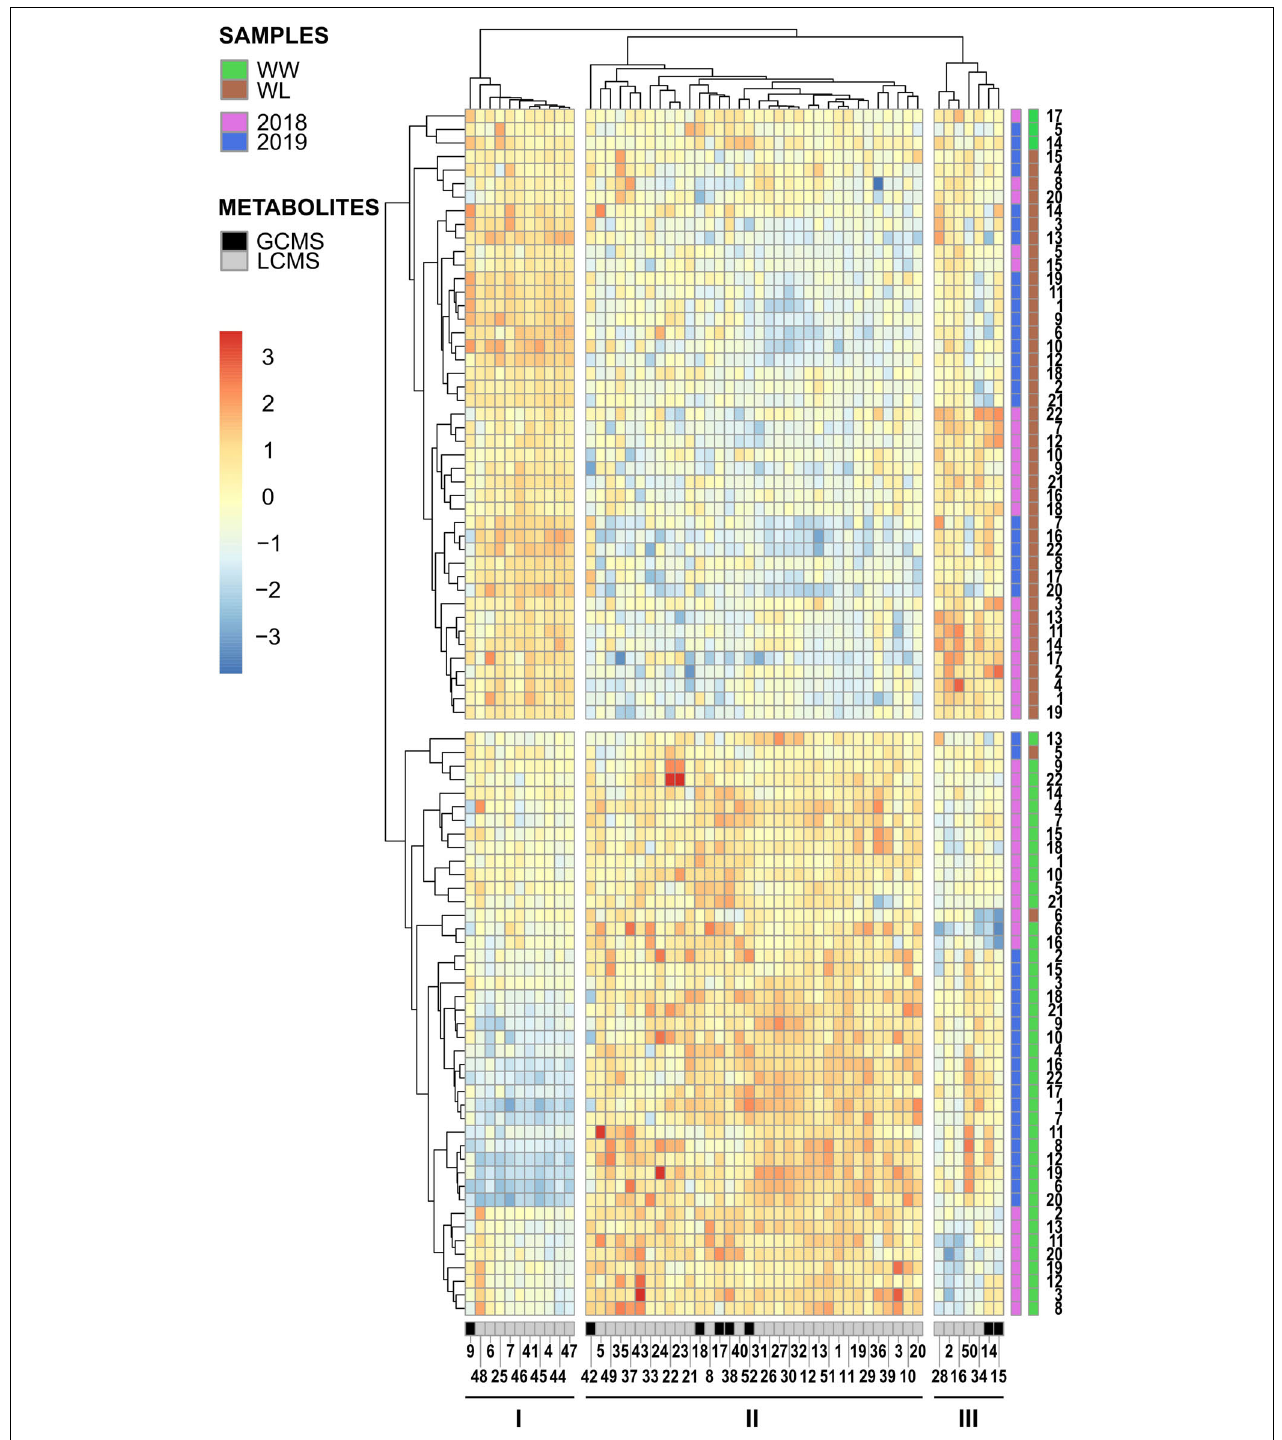
FIGURE 3 | Hierarchical clustering and heatmap of the 52 leaf metabolites identified in common among the 2018 and 2019 leaf samples of the 22 cotton accessions. The scale bar (red to blue) on the left represents normalized intensity of metabolite values. The black and gray bar at the bottom of the heatmap indicates if a metabolite was identified by GC–MS (black) or LC–MS (gray). The first side bar at the right of the heatmap indicates if a sample was collected in 2018 (pink) or in 2019 (blue). The second side bar at the right of the heatmap indicates if a sample was collected from a well-watered (WW = green) or a water-limited (WL = brown) field plot. The metabolite numbers at the bottom of the heatmap relates to the “2018–2019 clustering – Met. Number” column in Supplementary Tables 2, 3 . The black lines under the metabolite numbers indicate the three main metabolite clusters (I, II, and III). The sample numbers at the right of the heatmap relates to the “Current study number” column in Supplementary Table 1